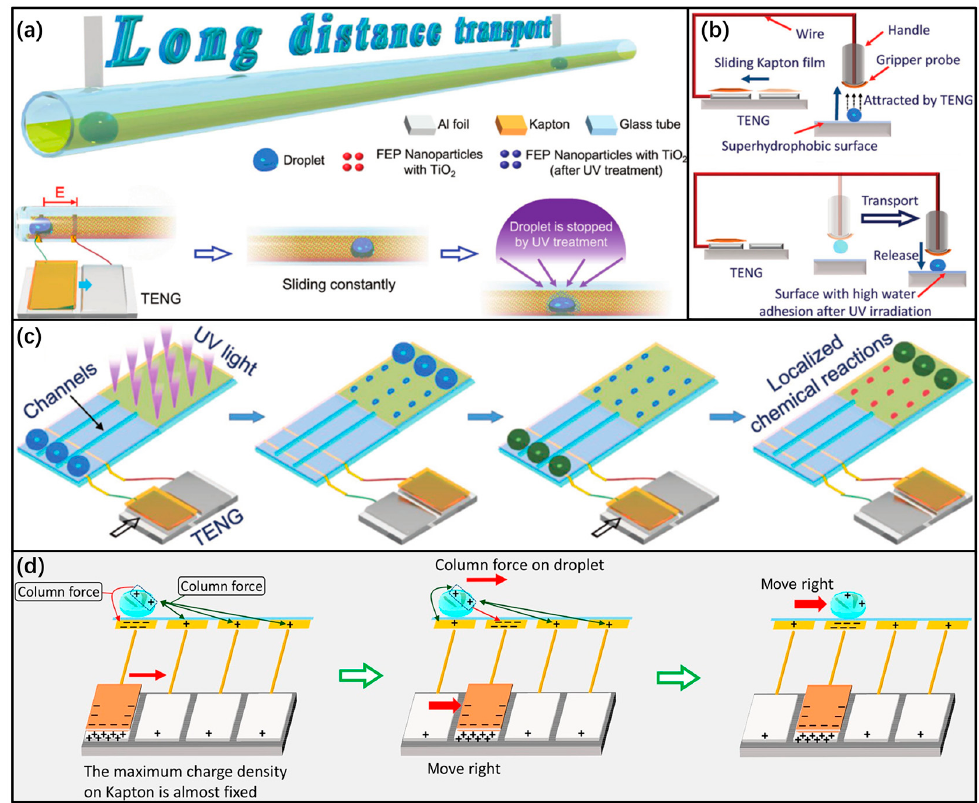
Figure 4. ( a ) The structure of the droplet driving system and ( b ) the motion process of the droplet [53]. ( c ) A model of the system is applied to chemical reactions [53]. ( d ) The working principle of the two-electrode system [54].